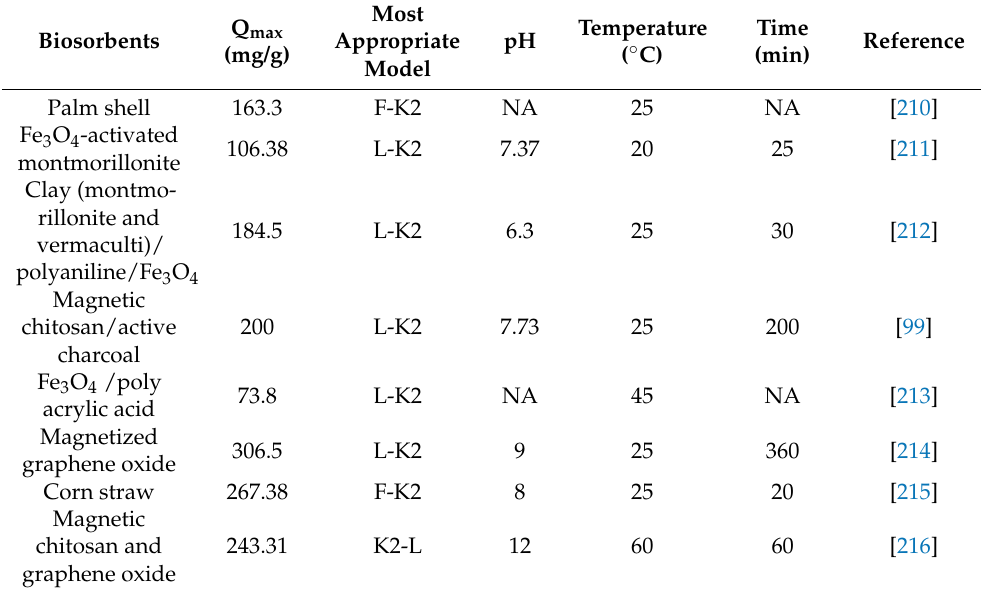
Table 8. Summary of bio-waste-derived adsorbent studies in